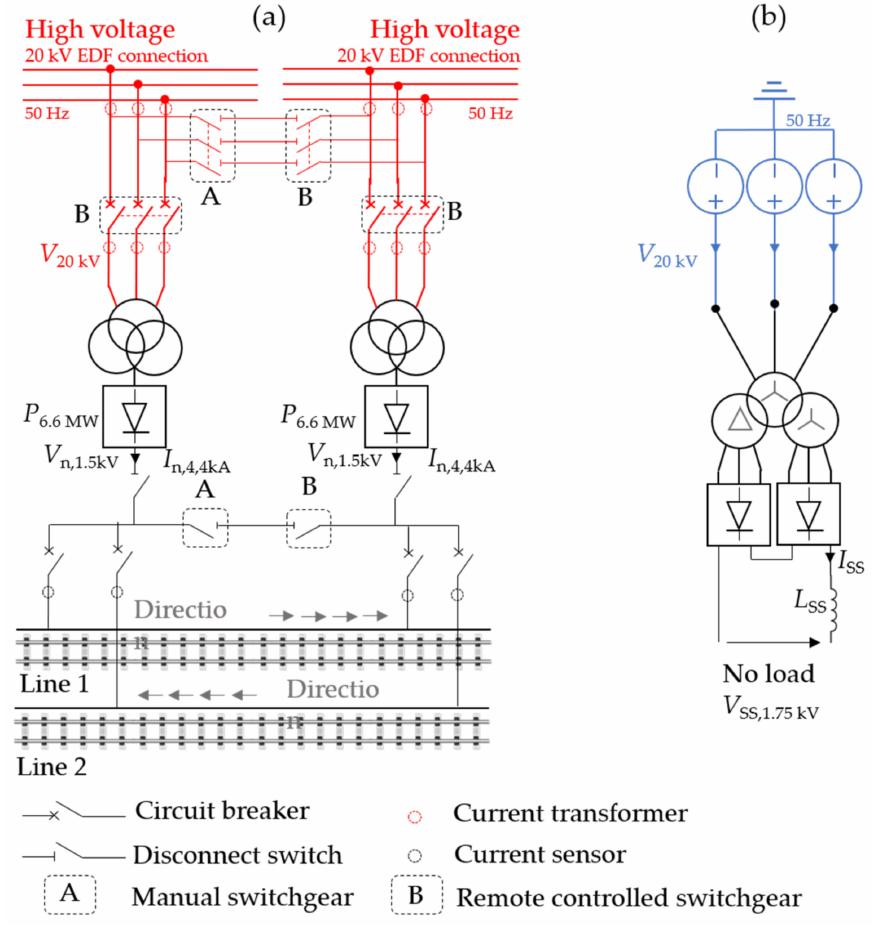
Figure 10. ( a ) Typical diagram of a 1.5 kV substation and the connection to the high voltage lines at 20 kV without showing the current return through the rails; ( b ) equivalent circuit of the substation implemented in Simulink. EDF is the acronym for Electricit é De